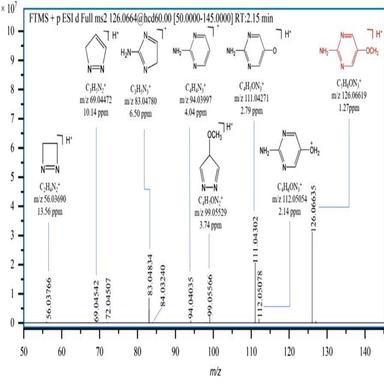
Product ion spectrum and proposed fragmentation pattern of OP-126.